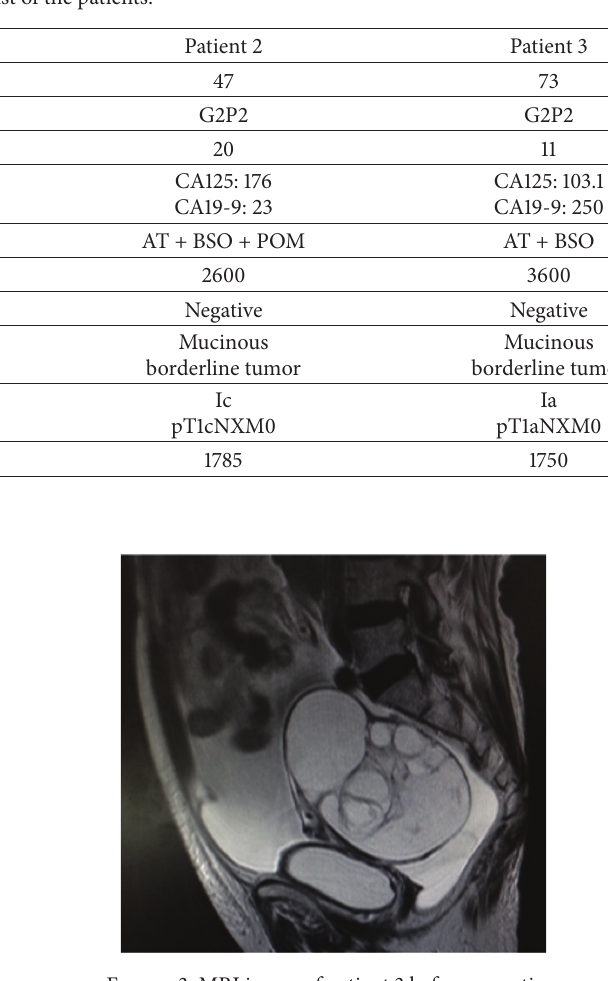
Figure 3: MRI image of patient 3 before